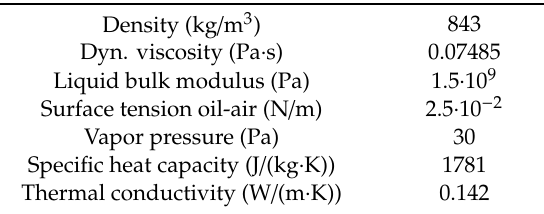
Table 2. Fluid properties of the automatic transmission oil at 20 ◦ C and 1 bar.